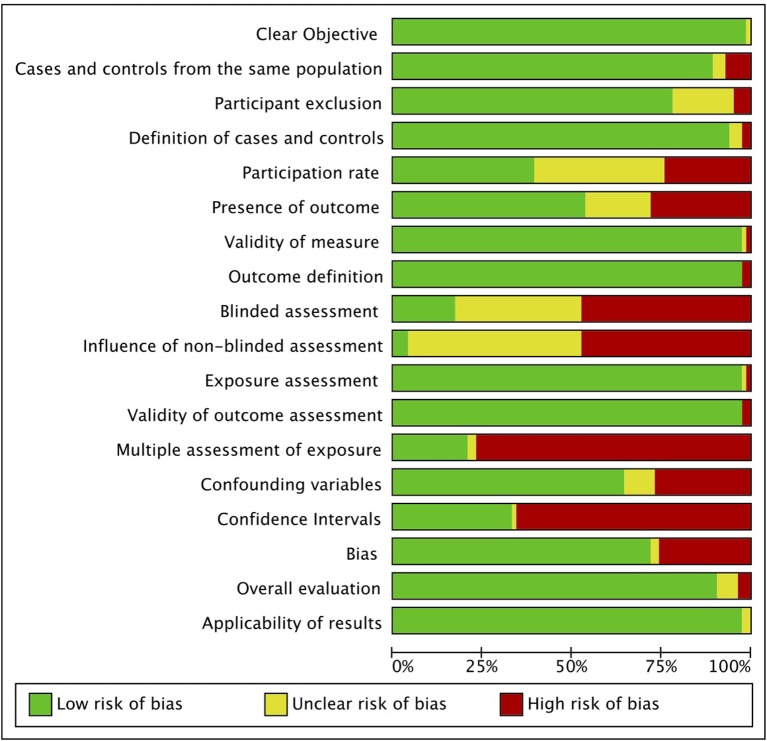
Risk of bias graph. Authors' judgments for each risk of bias item are presented as percentages across all included studies.